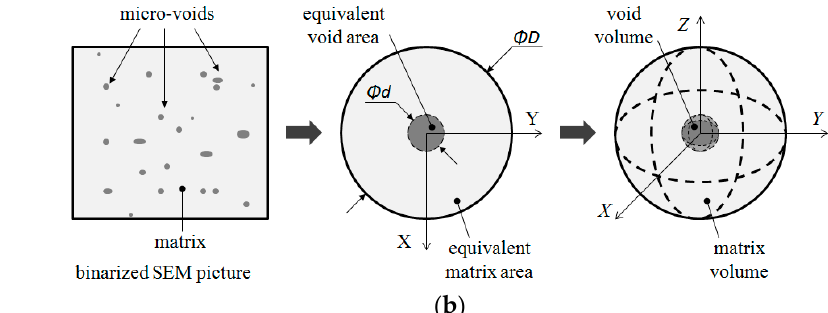
Figure 4. ( a ) Representative volume element (RVE): effective stress measure and ( b ) definition of the initial void volume fraction from the measured void area fraction [36].